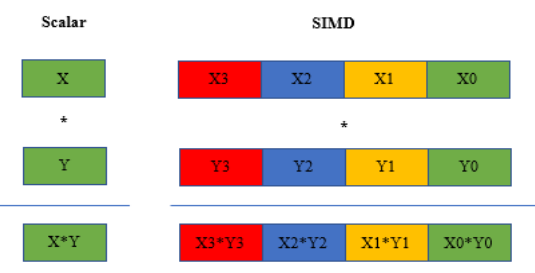
Figure 2. Scalar and single instruction multiple data (SIMD) multiplication comparison (the illustration is from Cadence Company technical material).